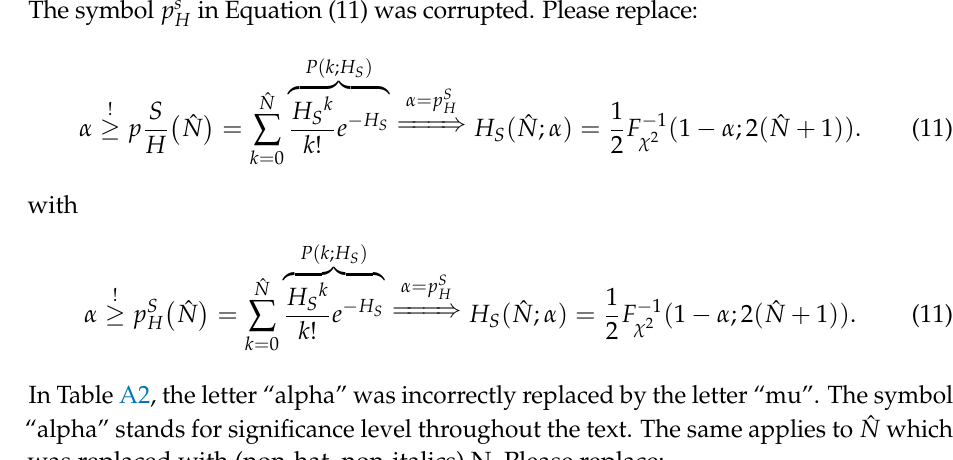
Table A2. Upper and lower limits of twin hypothesis testing for Frequentist ( L T and H T ) and Bayesian theorem ( L G ) probability intervals as calculated from Equations (A5), (A6) and (A12) for ˆ N observed fibers and a significance level of µ = 5%. Gray areas indicate fiber counts with relatively large intervals. Probability Interval Limits and Relative Errors for N Observed Fibers and µ = 5% Significance